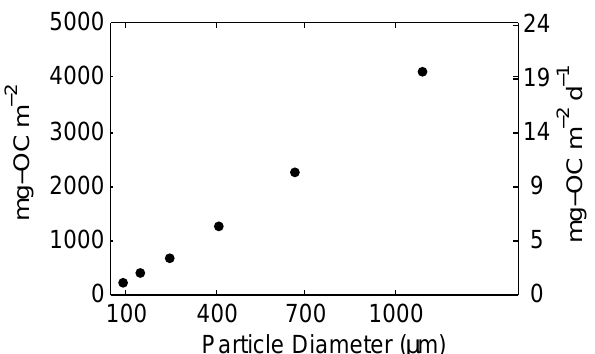
Fig. 11. Derived POC:attenuation cross section for large, solid par- ticles as a function of particle size (left y axis) and corresponding carbon flux for proxy value of 0.01m − 1 d − 1 , instrument pathlength of 0.25m, and 47% shading (right y